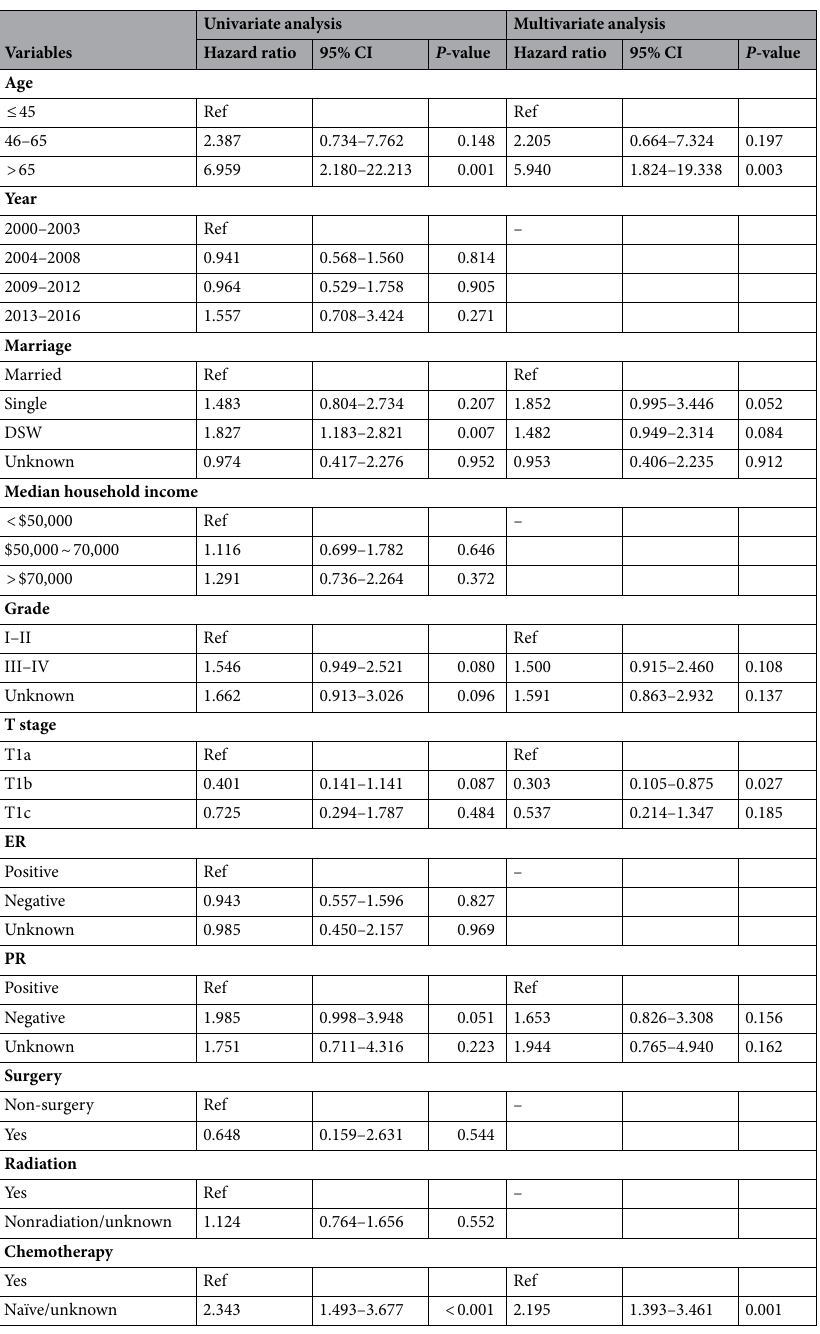
Table 3. Univariate and multivariate analysis of overall survival of MpBC patients. Abbreviations: CI, confidence interval; DSW, divorced/separated/widowed; ER, estrogen receptor; MpBC, metaplastic breast carcinoma; PR progesterone